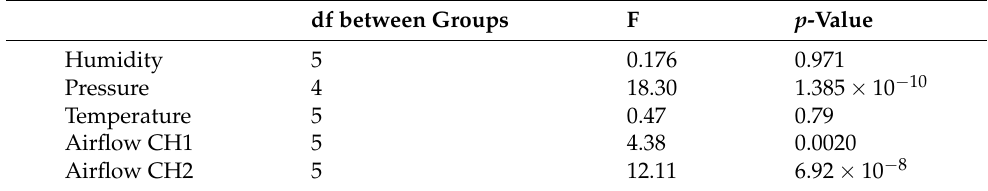
Figure 24. Peak to peak values of airflow (transducer right) as a function of the clogging level. Table 2. One-way Analysis of Variance performed on clogging level groups.